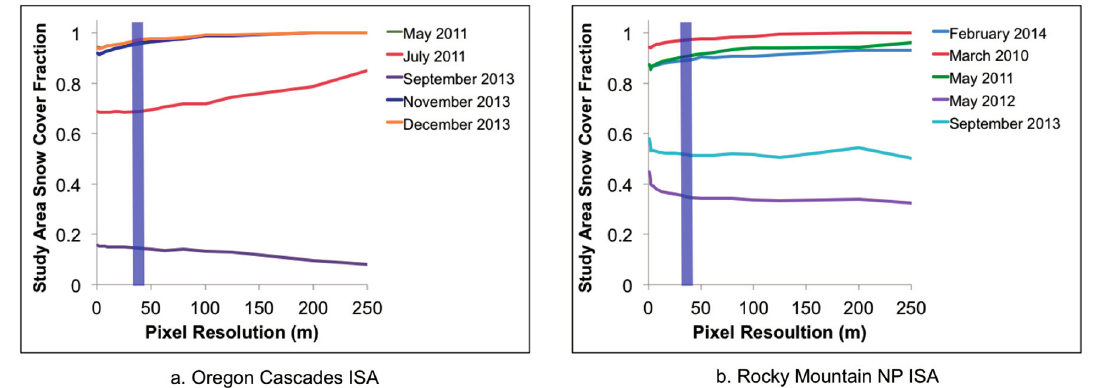
Figure 11. Relationship between pixel resolution and total study area snow cover fraction derived from binary SCA for ( a ) Oregon Cascades ISA ( b ) and Rocky Mountain NP imagery ISA. Vertical blue lines indicate 40 m, slightly above the nominal spatial resolution of Landsat.